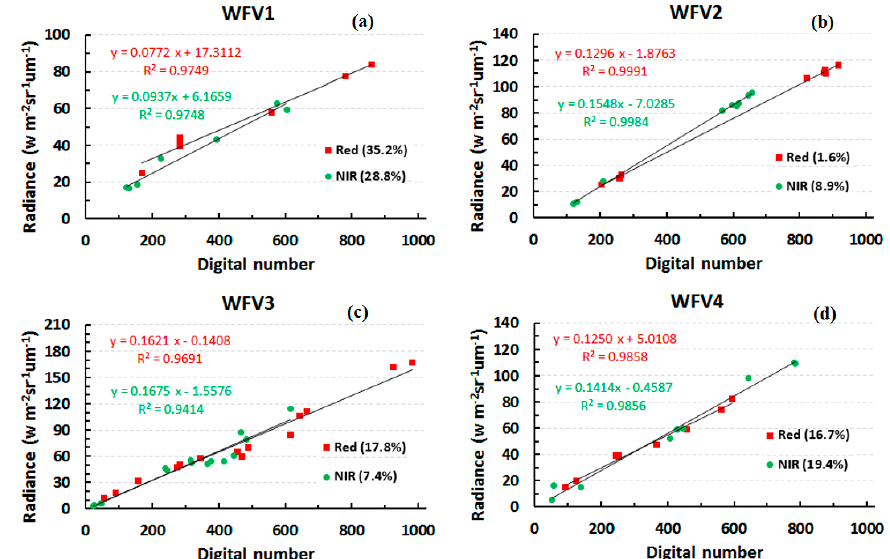
Figure 12. Cross calibration results using Moderate Resolution Imaging Spectroradiometer (MODIS) 250 m bands, where the homogenous ROIs were manually selected and the differences in spectral responses were adjusted. The differences between the MODIS- and OLI-cross calibrated gains (in percentage) for each band are also shown in the parentheses. ( a ) WFV1; ( b ) WFVV2; ( c ) WFVV3; ( d ) WFVV4.